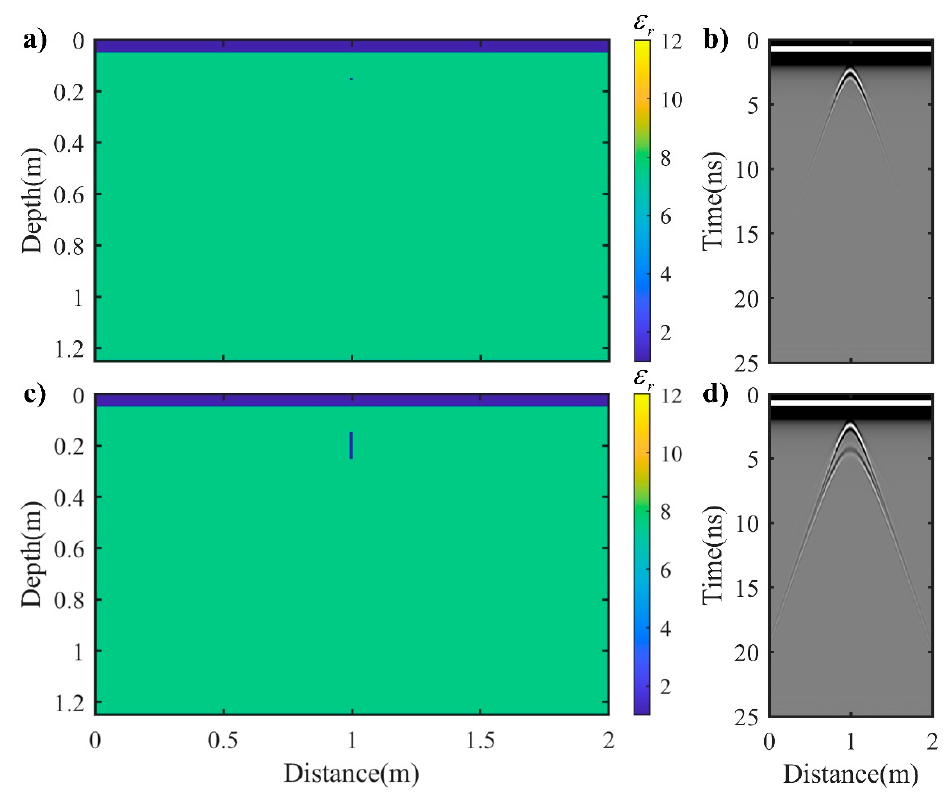
Figure 1. ( a ) Model 1 and ( c ) Model 2, ( b ) and ( d ) simulated GPR profiles for Models 1 and 2, re- spectively.